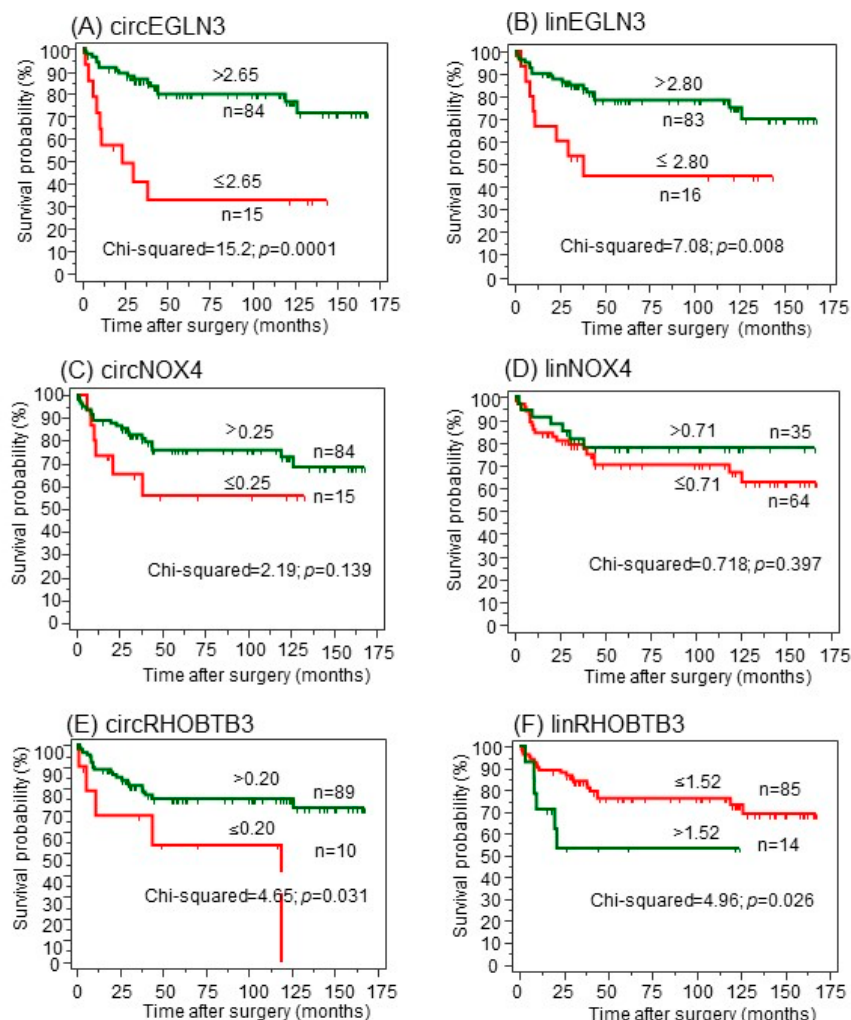
Figure 5. ( A – F ) Kaplan-Meier analysis of circular RNAs (circRNAs) and their linear transcripts with regard to cancer-specific survival after surgery. CircRNAs were dichotomized using the optimized cutoffs indicated by software X-tile [33] to discriminate between deceased and alive. Green curves represent patients with expression values above the cutoff; red curves represent patients with values equal or below the cutoff. The number of patients in the dichotomized groups and the cutoffs are indicated at the curves. The log-rank test was used to confirm significant differences between the survival probabilities.